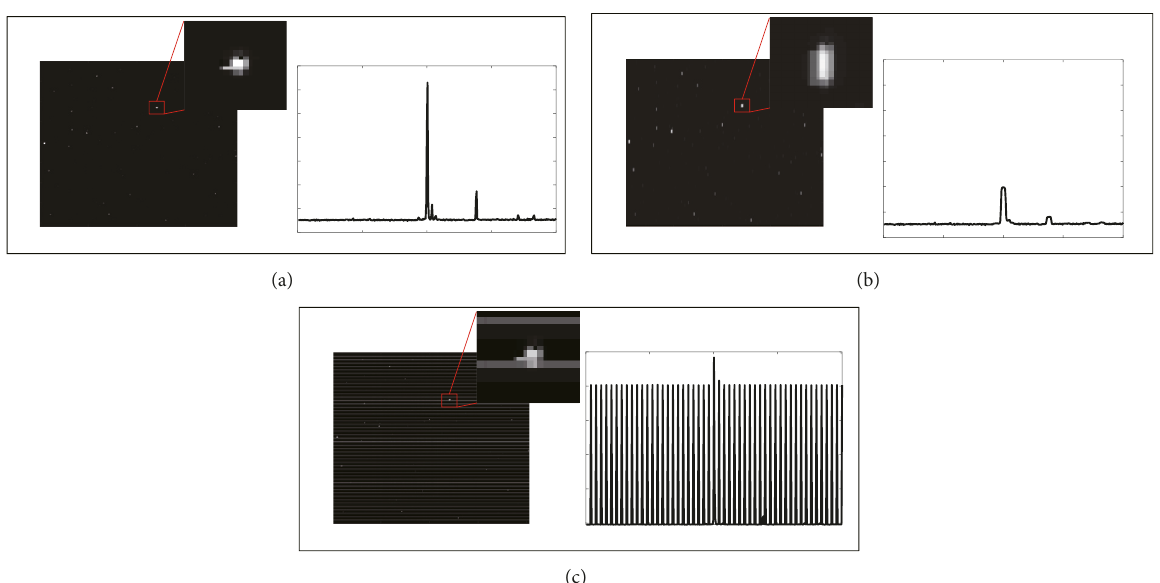
Figure 3: (a) The image taken by a ground-based telescope that is not affected by atmospheric dispersion and the gray distribution of the 309th column in the image. (b) The image affected by the atmospheric dispersion and the gray distribution of the 309th column in the figure. (c) The results of direct deconvolution from